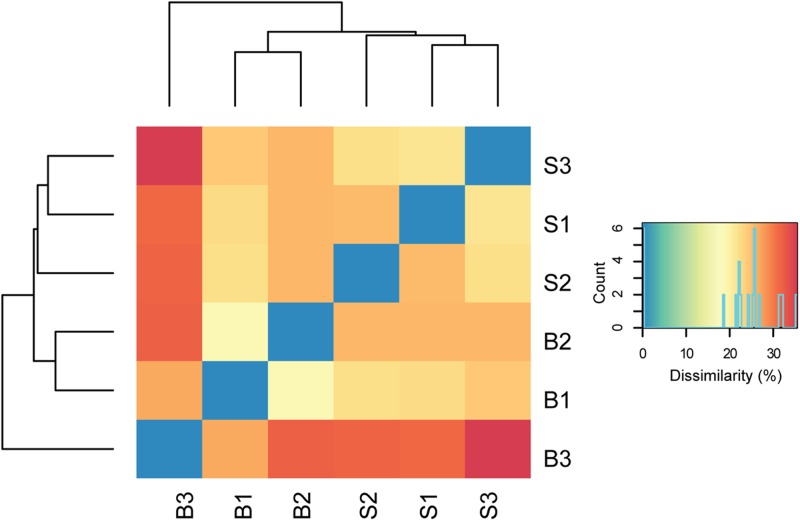
Dissimilarity of biological replicates and sampling time points. Euclidean distances between normalized read counts are shown, with blue indicating lowest distance. The dendrograms depict hierarchical clustering of replicates. Euclidean clustering was calculated based on all functional features detected (Supplementary Table S4). B1–B3 = baseline replicates, S1–S3 = SARA replicates.